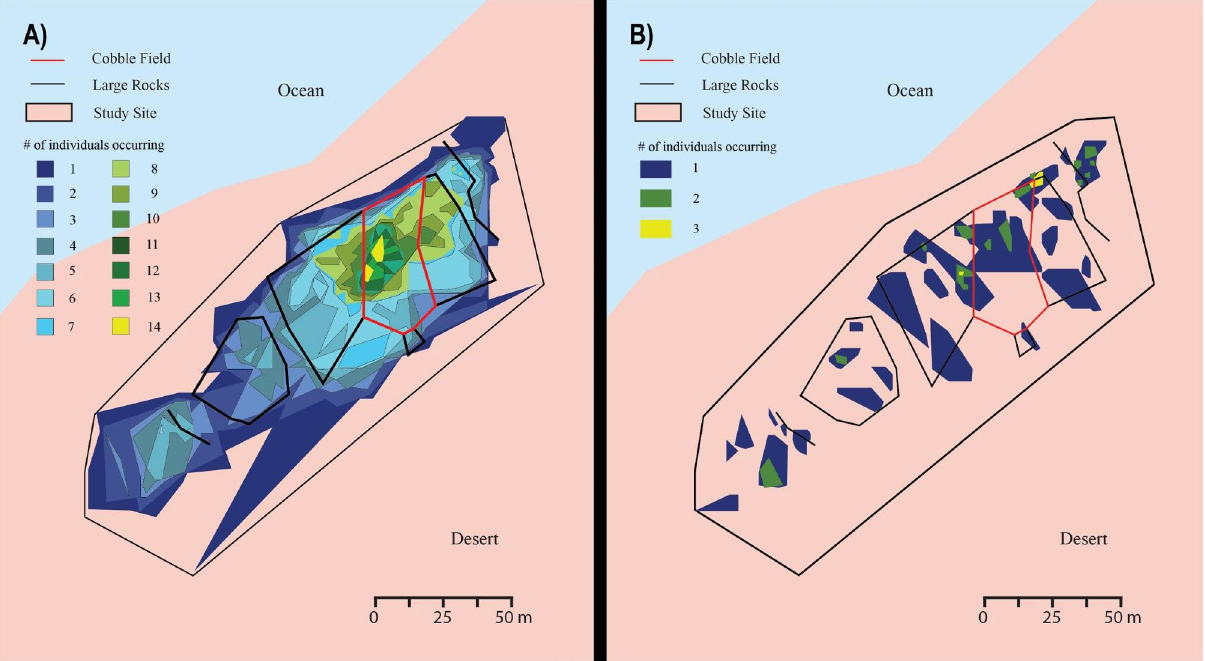
Fig. 5 Map of space use across site 2. (A) 100% MCPs (i.e., home ranges), with overlap concentrated in the largest cobble field outlined in red (depicted in Fig. 1 A). (B) 50% MCPs (i.e., core areas); note the much lower overlap among polygons. Location of study site relative to the ocean is illustrative of posi- tion and not to scale